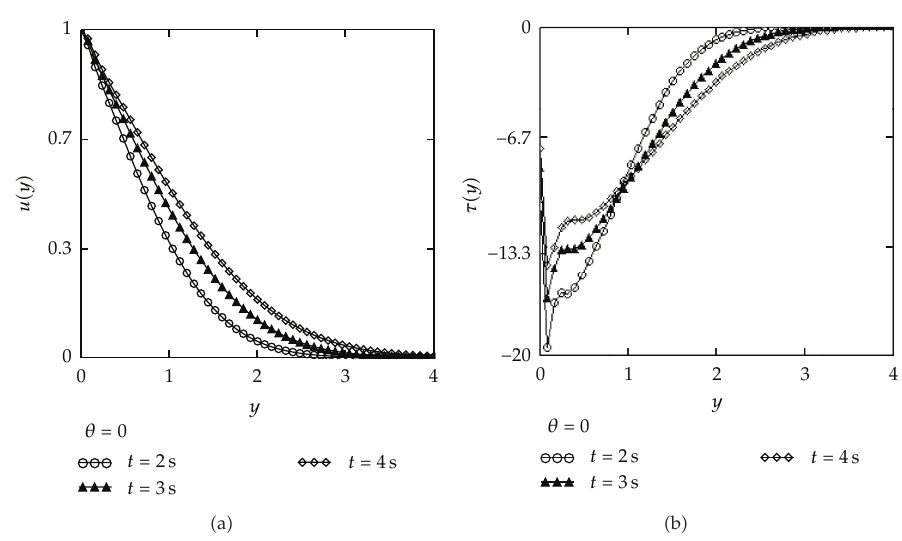
Figure 2: Profiles of the velocity field u (cid:4) y,t (cid:5) and the shear stress τ (cid:4) y,t (cid:5) for fractional Maxwell fluid given by (cid:4) 5.3 (cid:5) and (cid:4) 5.4 (cid:5) , for U (cid:9) 1, y (cid:9) 1, ν (cid:9) 0 . 379, μ (cid:9) 33, λ (cid:9) 1 . 5, α (cid:9) 0 . 2, θ (cid:9) 0 . 0, and di ff erent values of t .